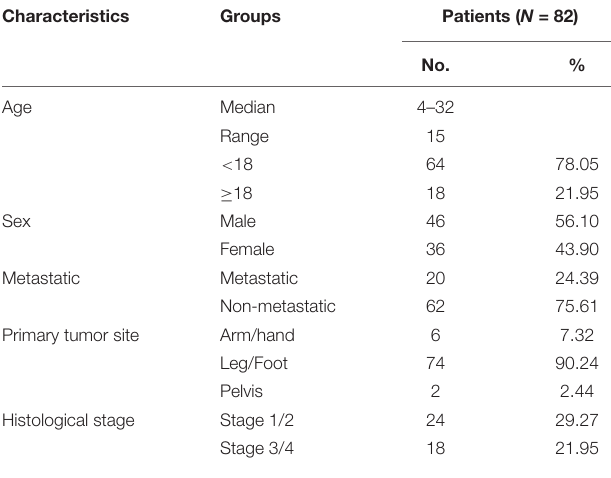
TABLE 1 | Clinicopathological characteristics of osteosarcoma